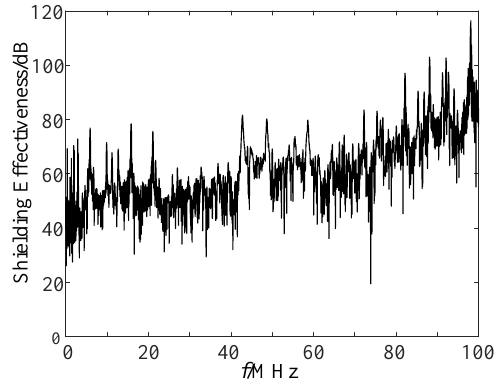
Figure 16. Shielding effectiveness of the FTU shell.